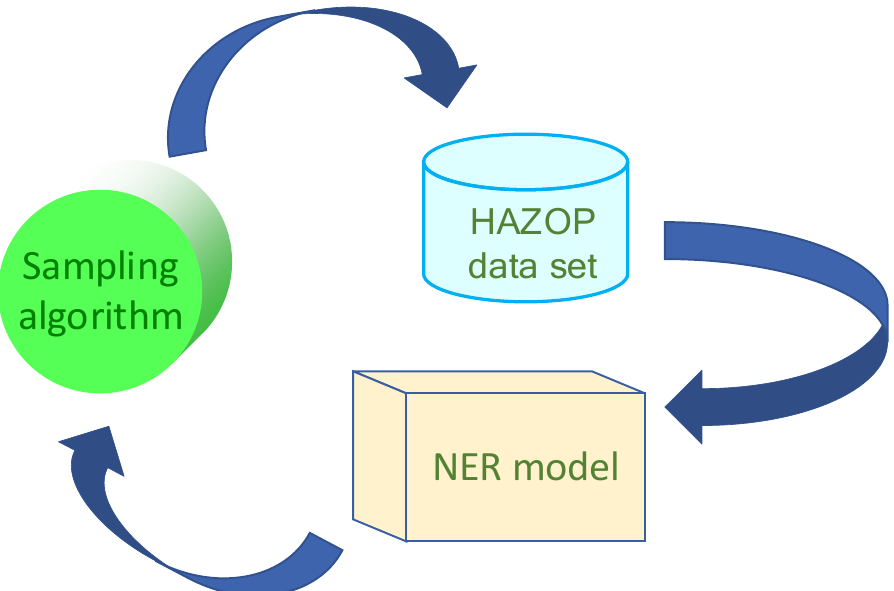
Figure 5. Illustration of the training process.